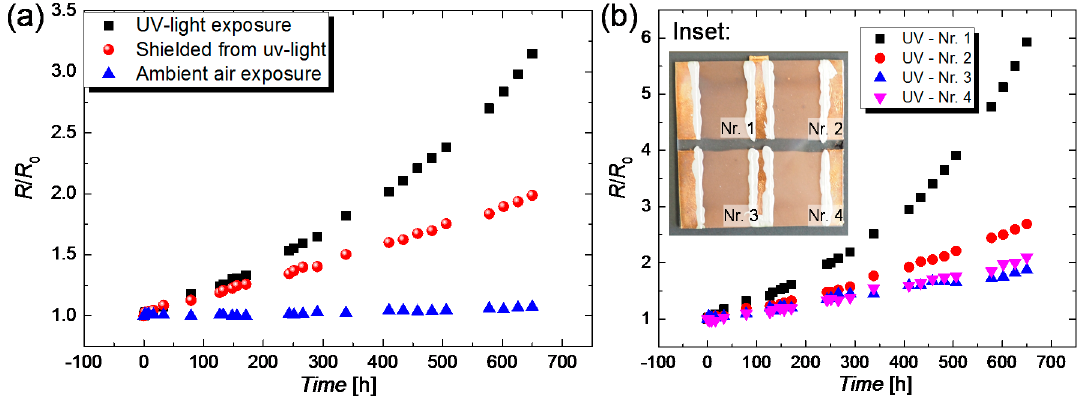
Figure 10. ( a ) Normalized increase in resistance R / R 0 over time for CuNW films with a transmittance of 70% that were (i) subjected to ultraviolet-visible (UV-vis) light, (ii) shielded from UV-vis light and (iii) exposed to the ambient air. Each symbol represents a mean resistance that was determined by averaging over four different samples; ( b ) R / R 0 over time for four different CuNW films that are subjected to prolonged UV-vis exposure. The inset depicts the four CuNW samples that were subjected to UV-vis exposure along with a labeling that is in accordance with normalized resistance curves.